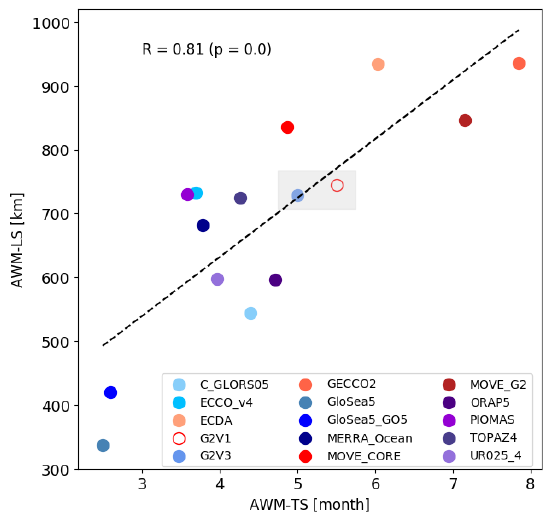
Figure 14. Scatter plot of the average weighted mean (AWM) timescale vs. the AWM length scale. The black dashed line indicates the linear regression between both parameters, while the coefficient of correlation ( R ) is also displayed in the plot. The gray rectangle compares the two GLORYS systems: G2V1, built without sea